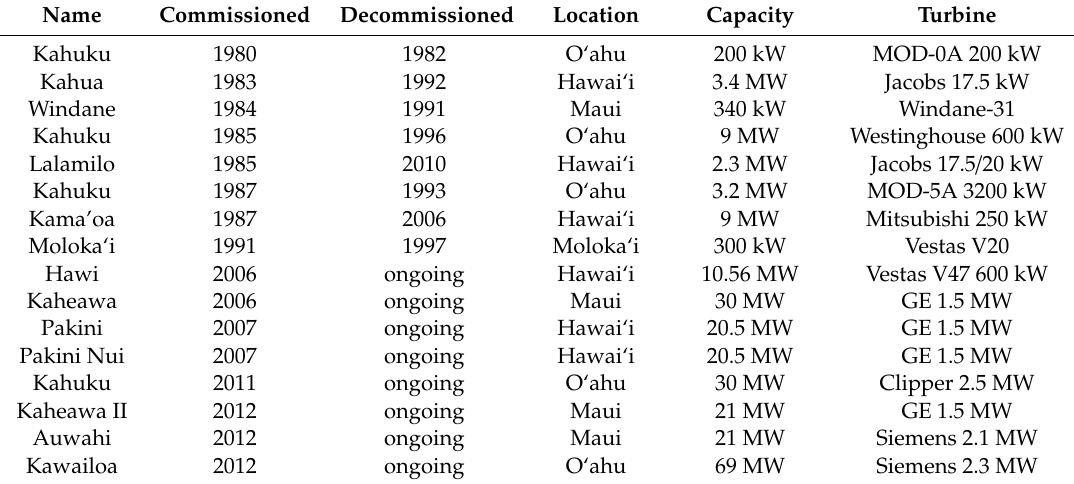
Table 1. Hawai‘i wind power developments 1980–2020.